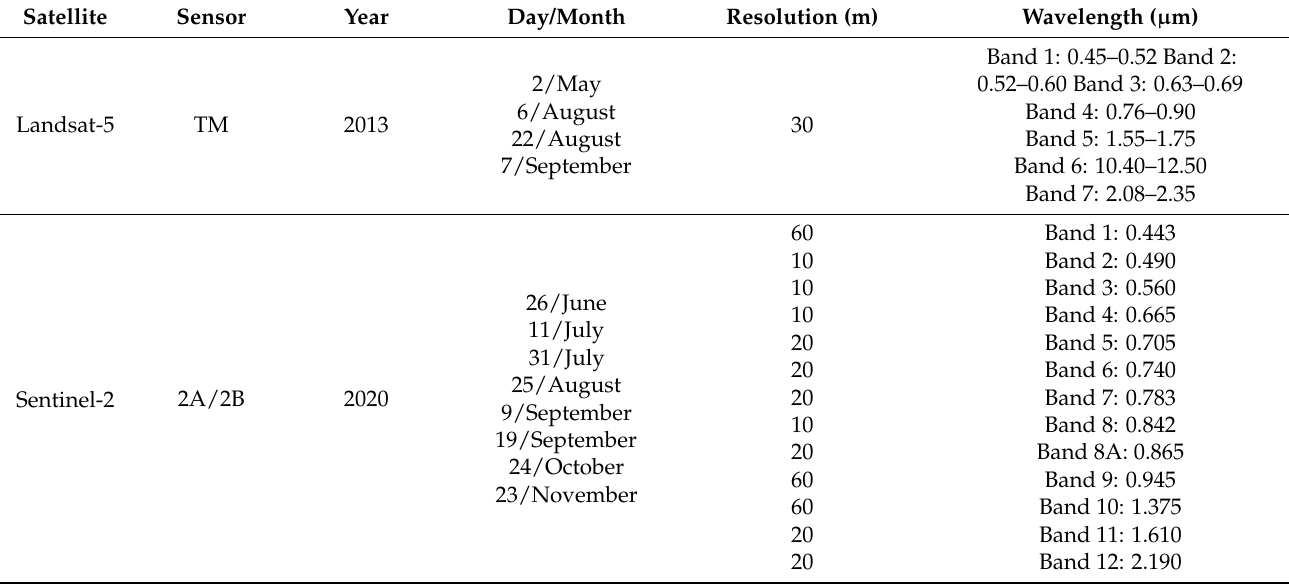
Table 1. Specifications of Landsat-5 and